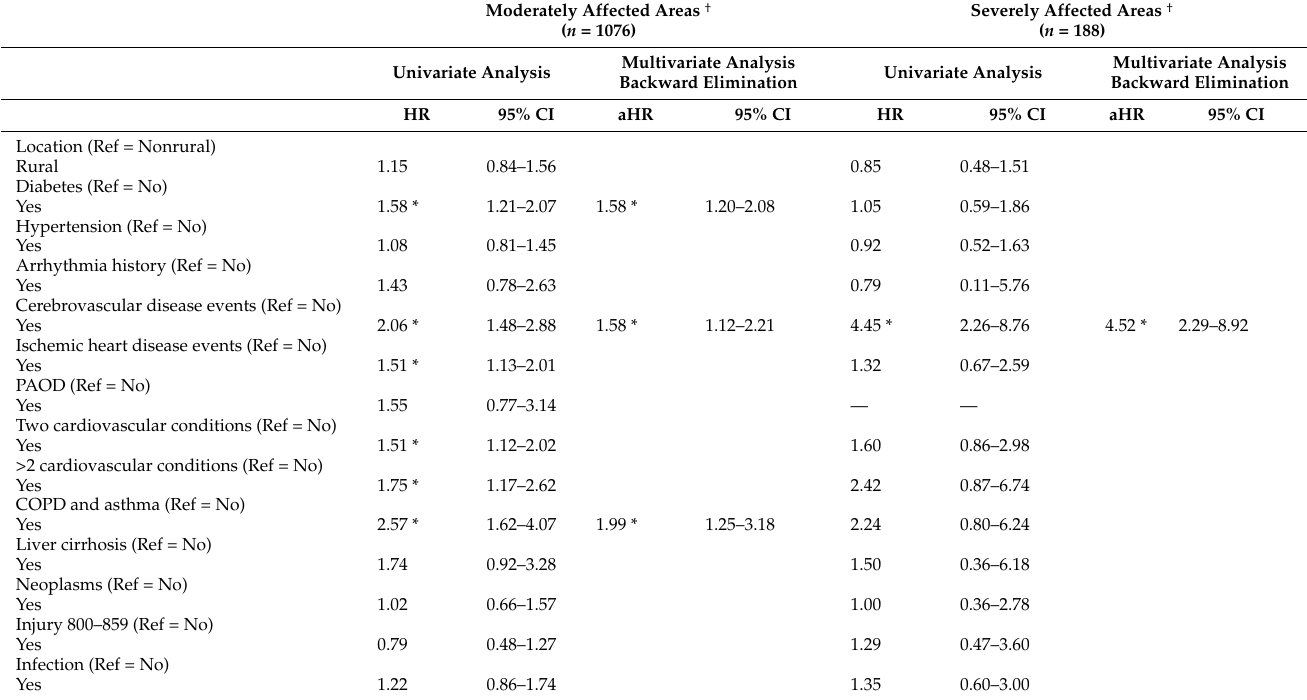
Table 4. Hazard ratio for all-cause mortality in adults on dialysis in moderately and severe affected areas after Typhoon Morakot.